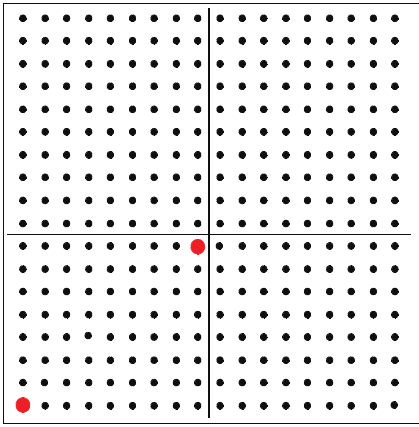
Figure 13: Observation plane divided into 4 quadrants.